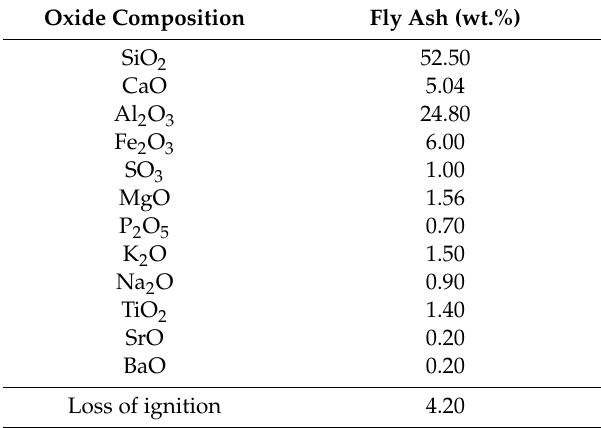
Table 1. Chemical composition of fly